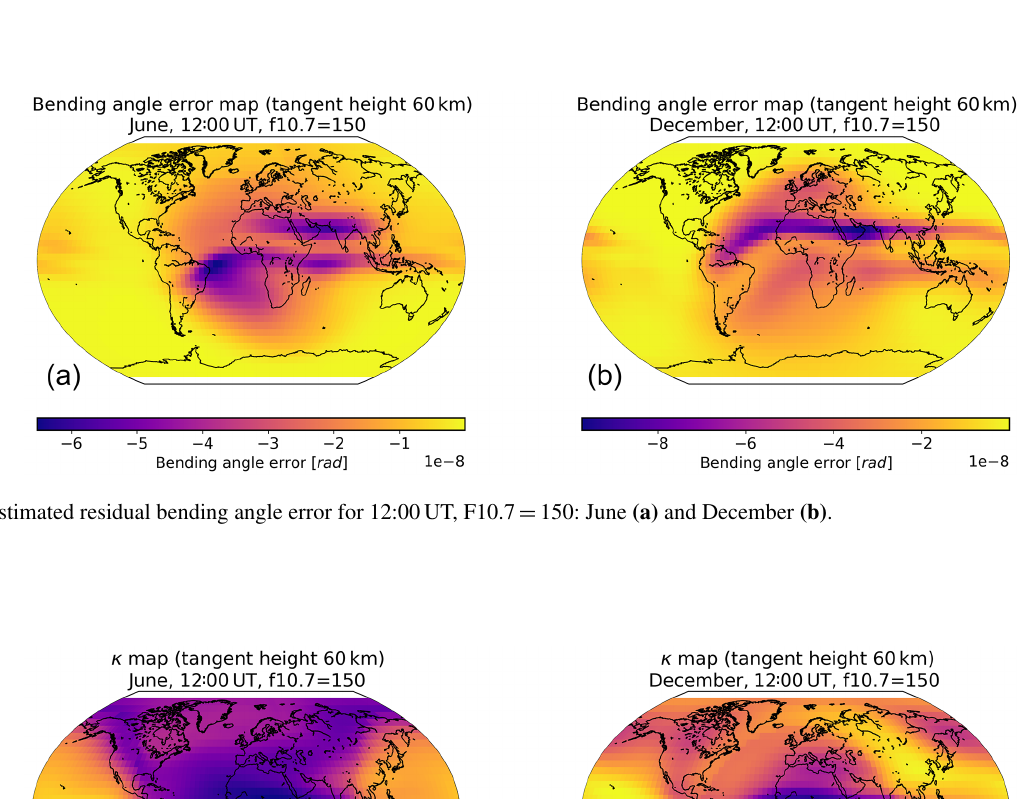
Figure 6. Vertical TEC from NeQuick for 12:00UT, F10.7 = 150: June (a) and December (b) . 1TECu = 1 × 10 16 electronsm − 2 .